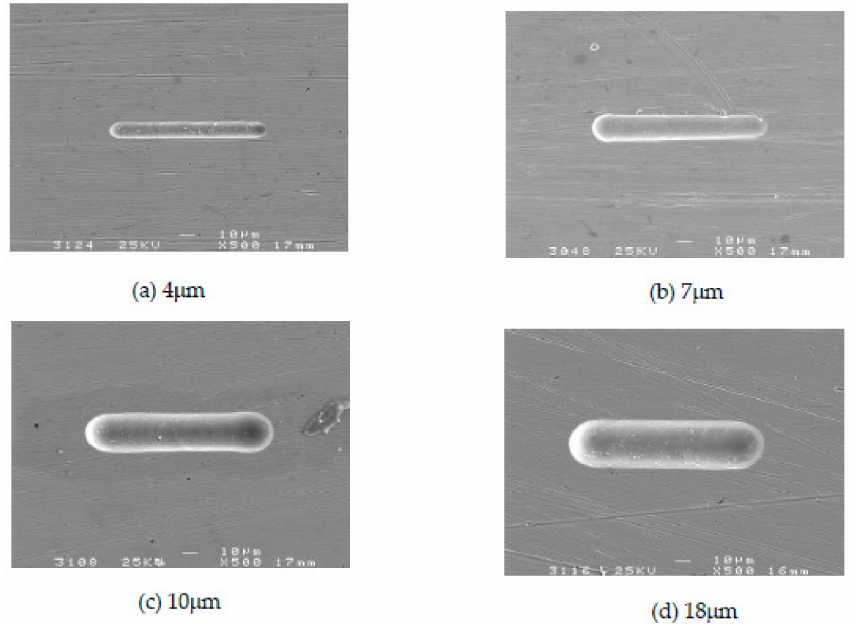
Figure 14. The SEM images of the microgroove under different electrode diameters. ( a ) 4 µ m; ( b ) 7 µ m; ( c ) 10 µ m; ( d ) 18 µ m.